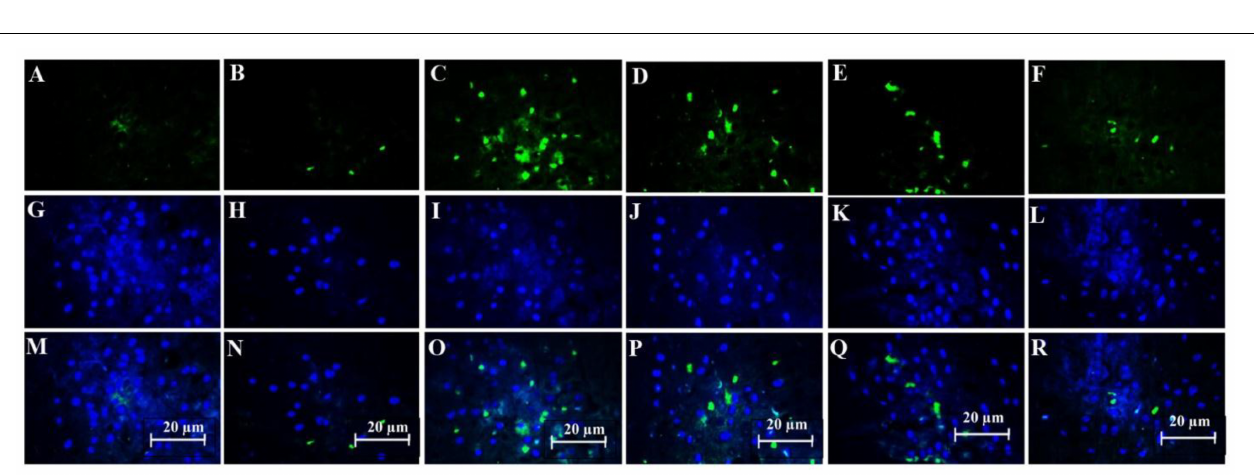
FIGURE 6 | Effect of SDF-1 and G-CSF on the amount of anti-beta amyloid deposition in the cortex of all experimental groups: (A) (Control), (B) (Sham), (C) ( β A), (D) (G-CSF), (E) (SDF-1), (F) (G-CSF&SDF-1); DAPI (G–L) , Merge (M–R) .